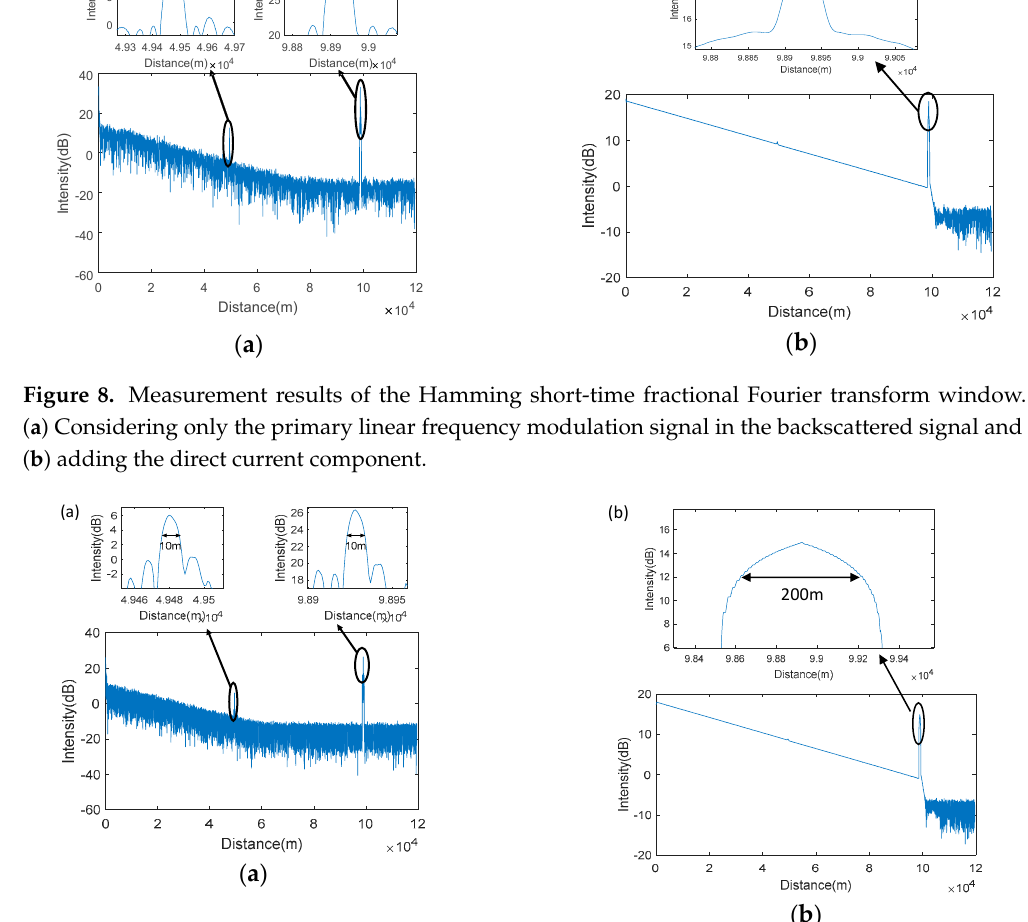
Figure 9. Measurement results obtained by extracting the tertiary LFM signal. ( a ) Considering only the tertiary LFM signal in the backscattered signal and ( b ) adding the direct current component.